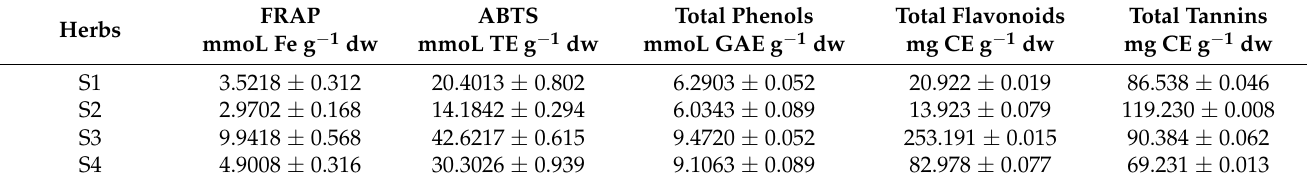
Table 2. Antioxidant capacity and total phenol, flavonoid and tannin contents in aqueous plant extracts.